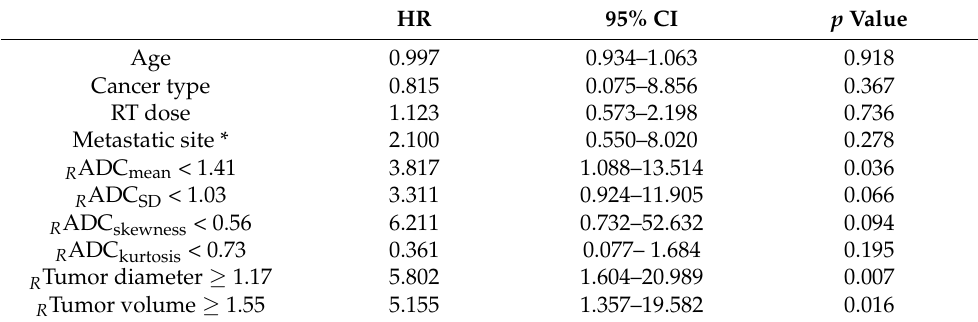
Table 3. Cox regression analysis for relation between MRI-derived parameters and local disease progression.